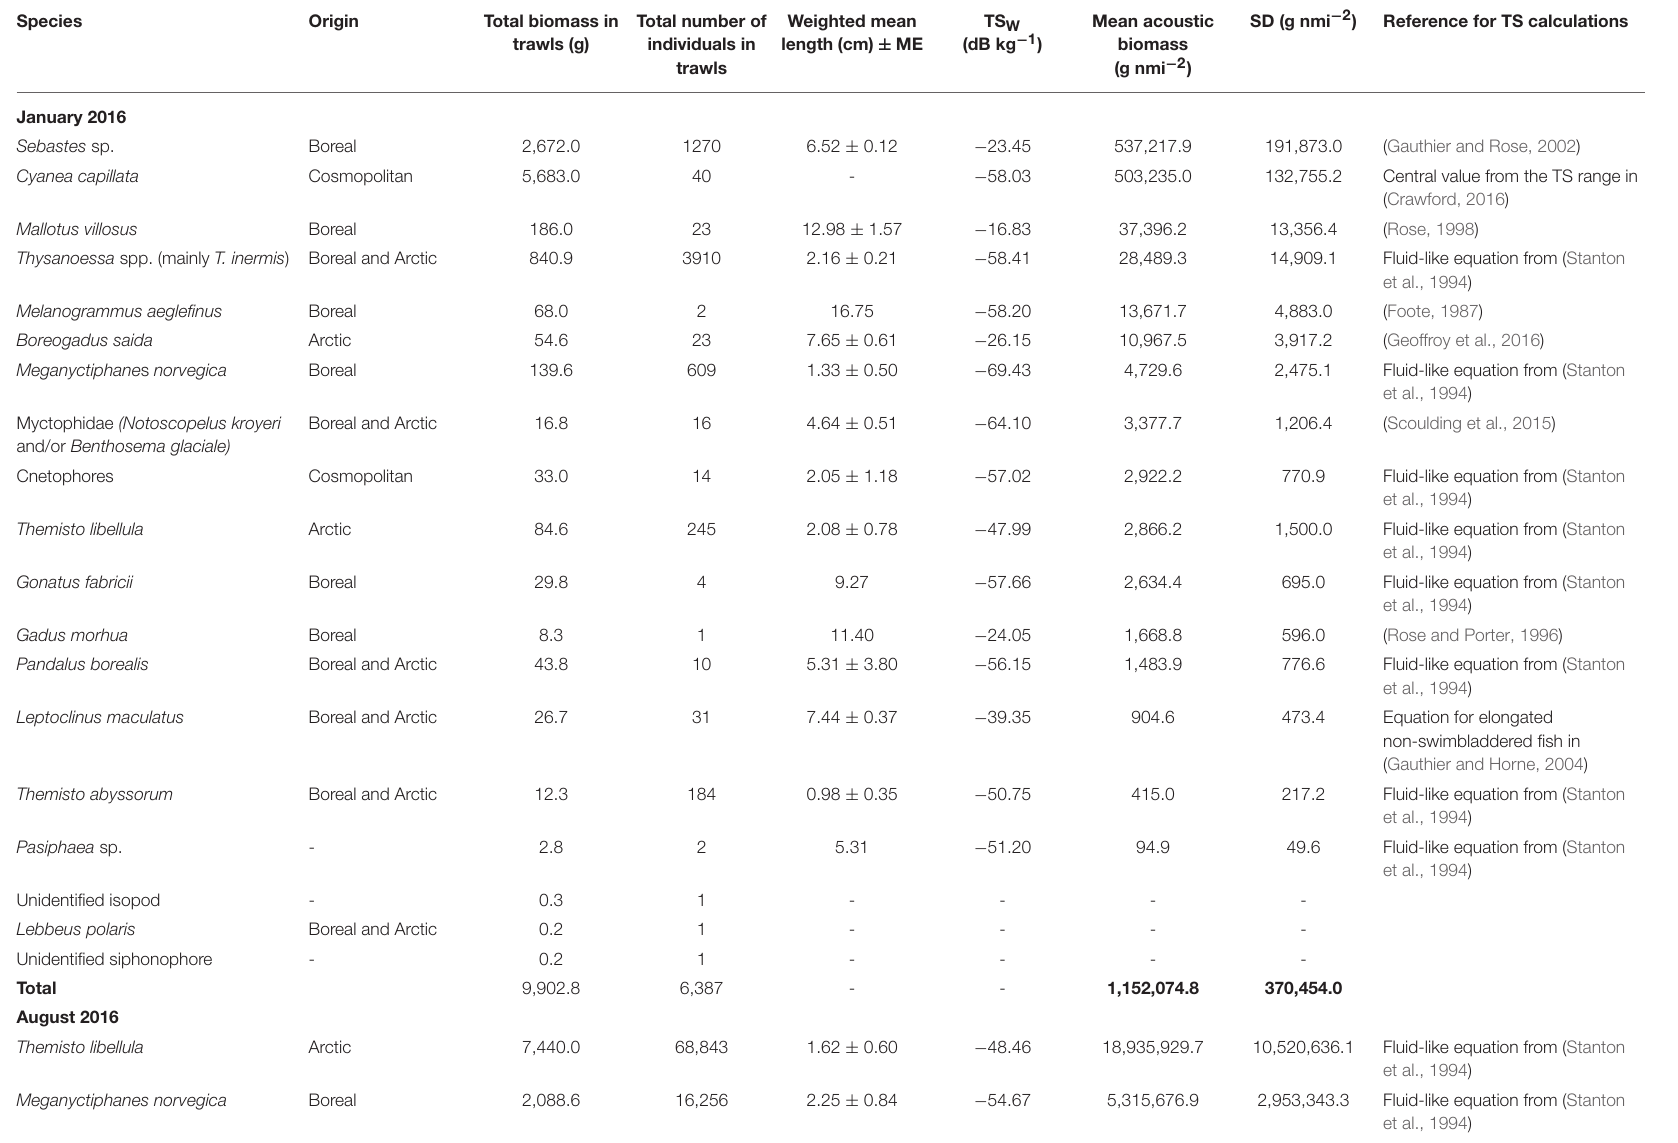
TABLE 1 | Details of all mesopelagic organisms sampled offshore (bottom depth >